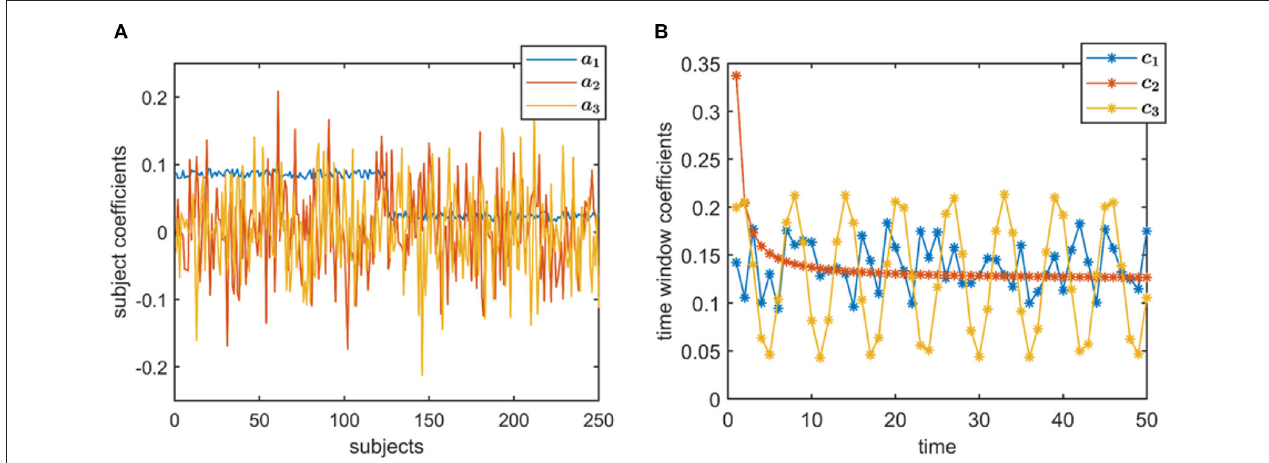
FIGURE 2 | True factors used to generate simulated data. (A) Subject-mode factors, where a r indicates the columns of A , for r = 1,2,3, and (B) Temporal patterns, where c r indicates the columns of C , for r = 1,2,3. Time, here, is in the resolution of time windows, but may also correspond to time samples depending on the application.